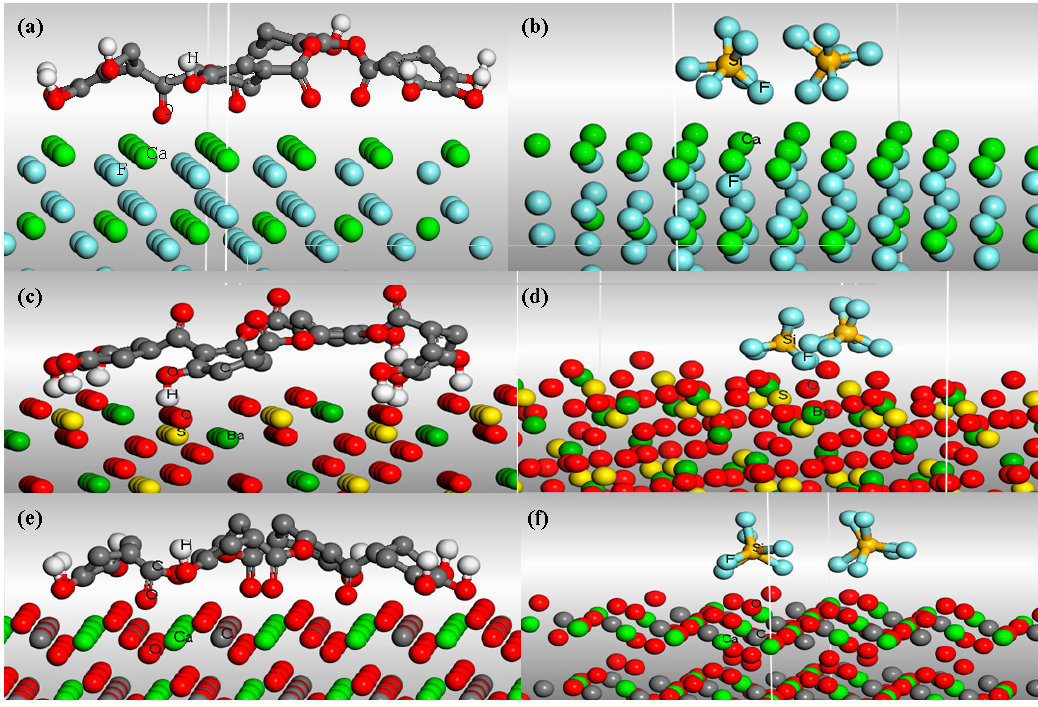
Figure 10. The optimized adsorption models of depressants on mineral surface: ( a ) tannin on fluorite surface; ( b ) sodium fluosilicate on fluorite surface; ( c ) tannin on barite surface; ( d ) sodium fluosilicate on barite surface; ( e ) tannin on calcite surface; ( f ) sodium fluosilicate on calcite surface.